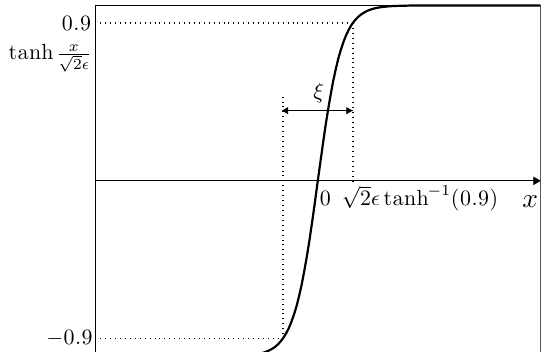
Figure 4. Concentration field varying from 2 √ 2 (cid:101) tanh − 1 ( 0.9 )